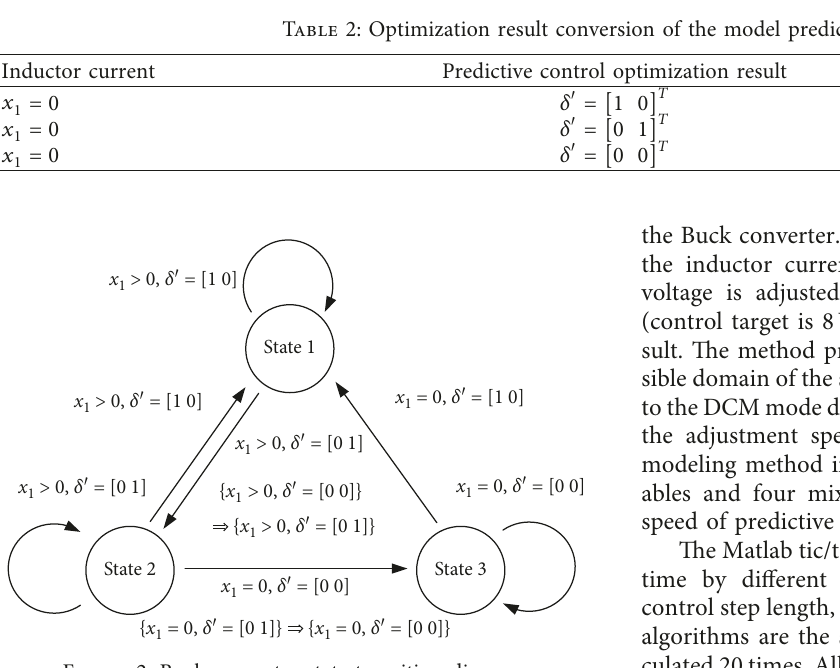
Figure 2: Buck converter state transition diagram.